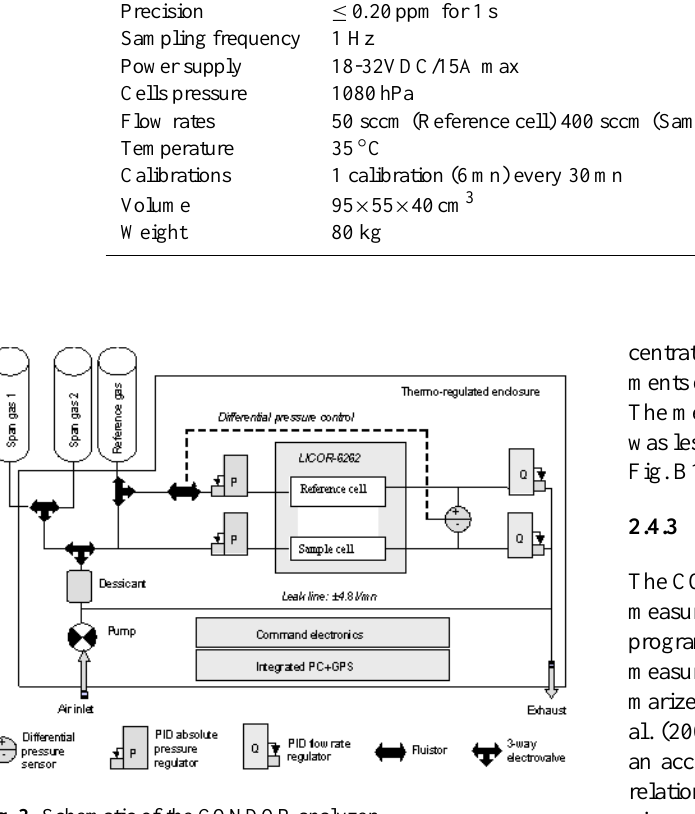
Fig. 3. Schematic of the CONDOR